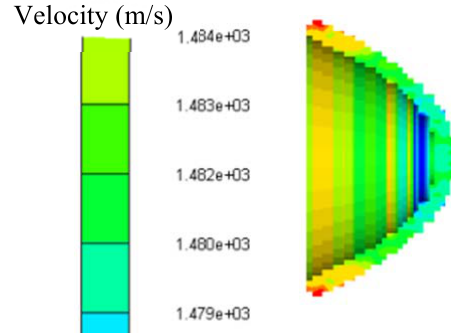
Figure 9. Penetrator velocity of EFP with casing made of aluminum (Autodyn) [8]